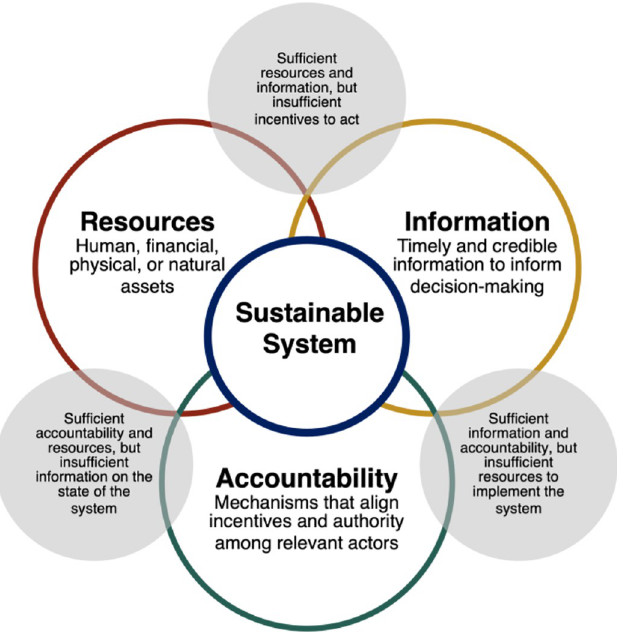
Fig 3. Resources, information, and accountability are each necessary, but insufficient components of sustainable service delivery systems.